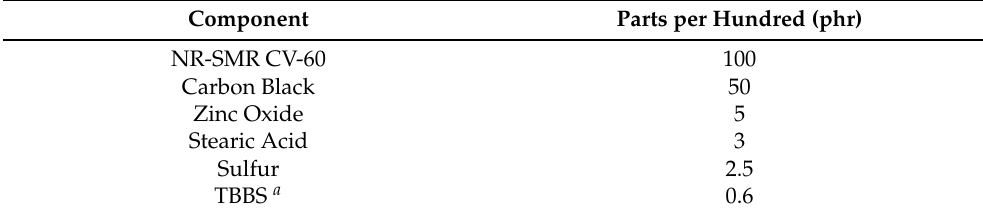
Table 1. Material formulation of tested samples. Component Parts per Hundred